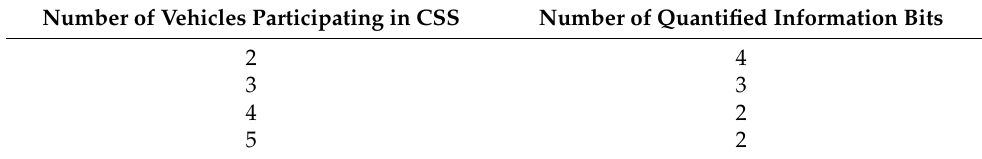
Table 3. Candidate optimal combination